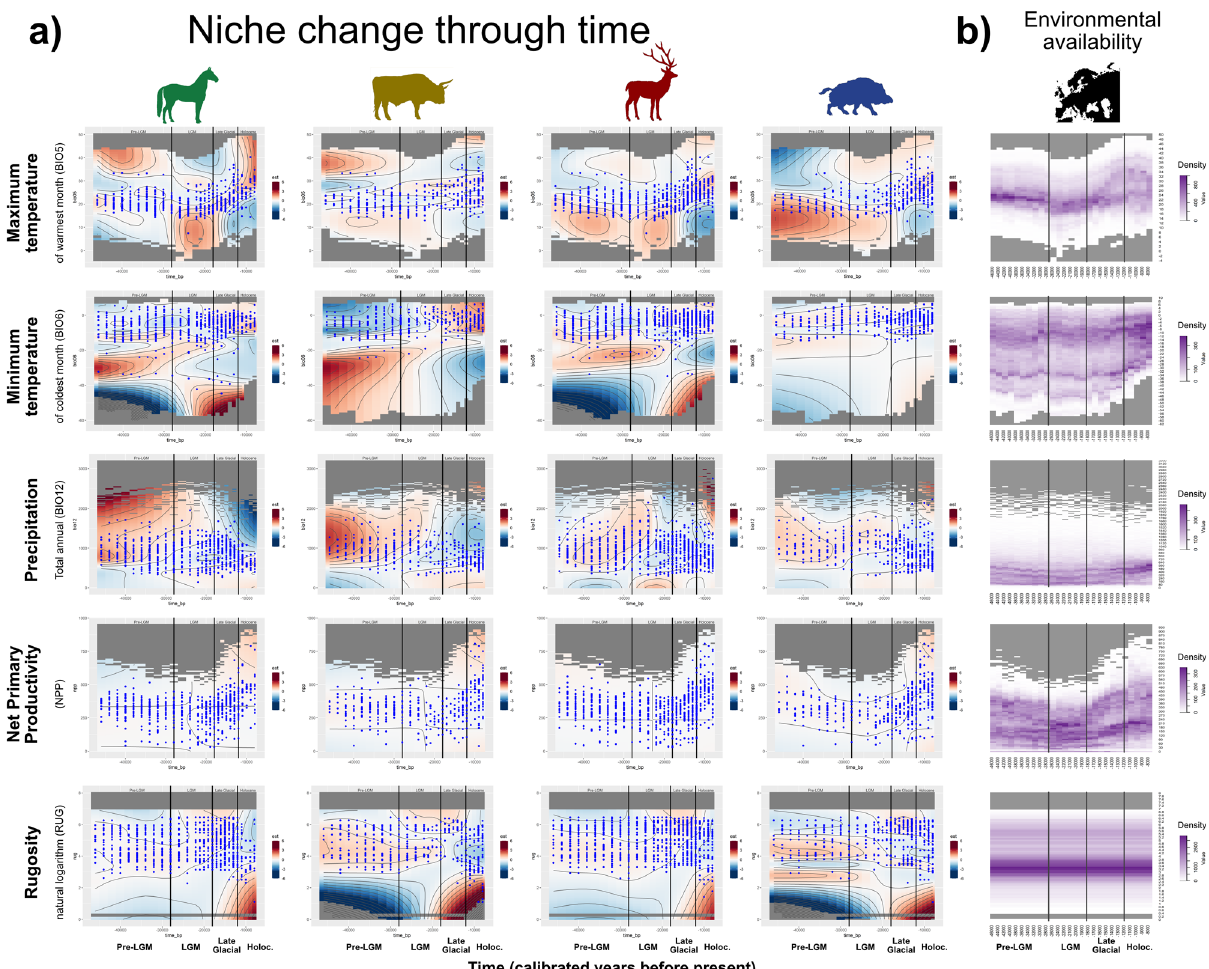
Fig. 6 Interaction plots. a Depiction of how the niche changed through time through heatmaps of the interaction between the environmental variables ( y - axis) and time ( x -axis): red represents areas in the variable space with higher relative preference, while blue is the opposite (see main text for a more detailed explanation). The colour scale is the same in all plots, black contours are isolines, and the blue dots show the distribution of the species observations for each time slice. b Environmental availability, i.e., density of each variable within Europe through time (the darker the shade, the higher the density). The variables are on the y -axis and time on the x -axis; the colour scales are the same across